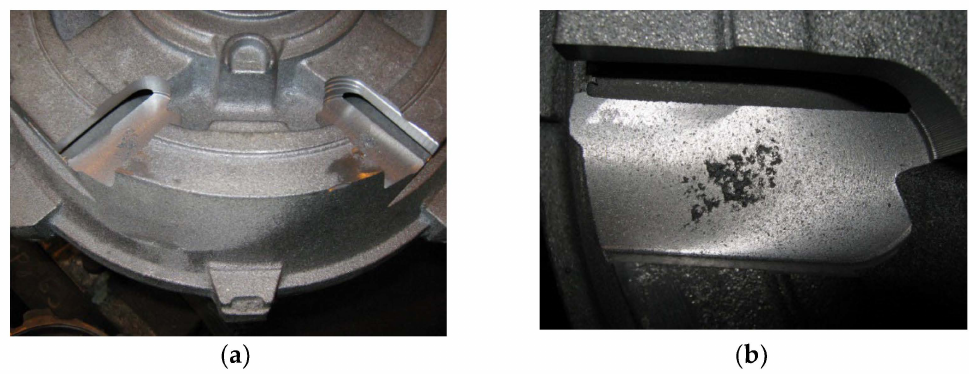
Figure 6. ( a ) Place of appearance of porosity in cast of motor shield and ( b ) appearance of defect.